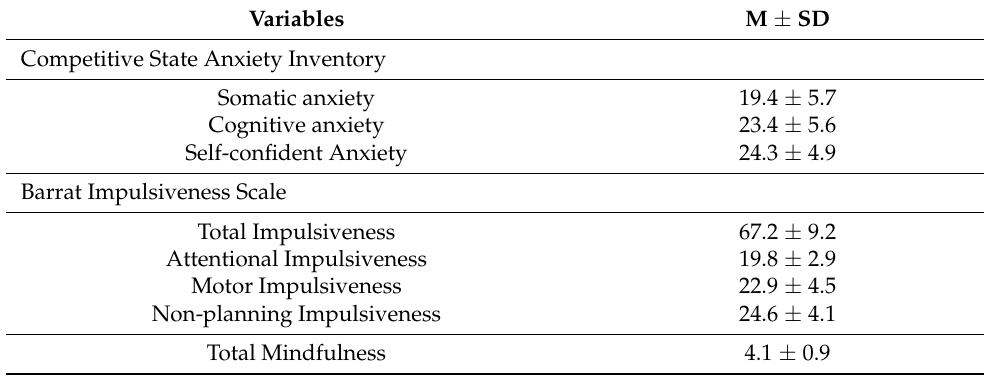
Table 2. Anxiety, impulsiveness, and mindfulness of the study